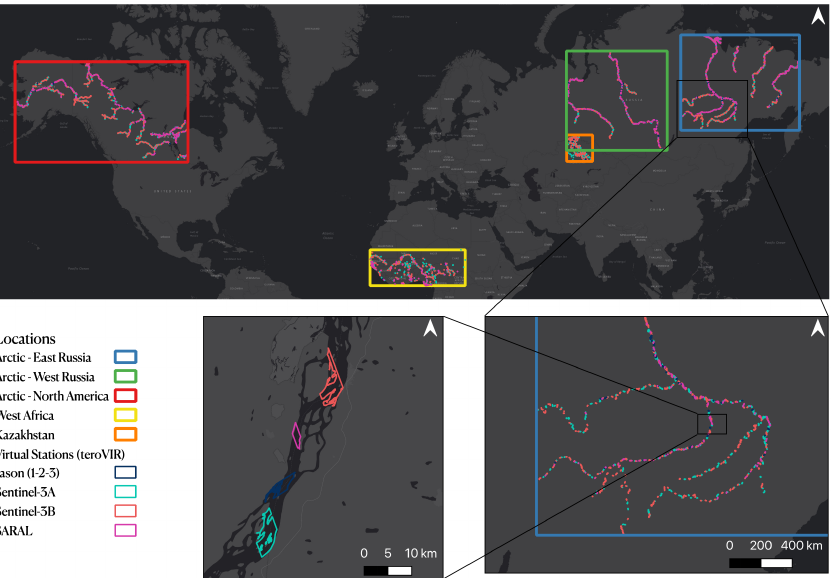
Figure 4. Virtual stations provided by teroVIR in the different Areas Of Interest (background from ESRI). Table 2. Benchmark of virtual stations provided in different areas of interest by the different platforms.